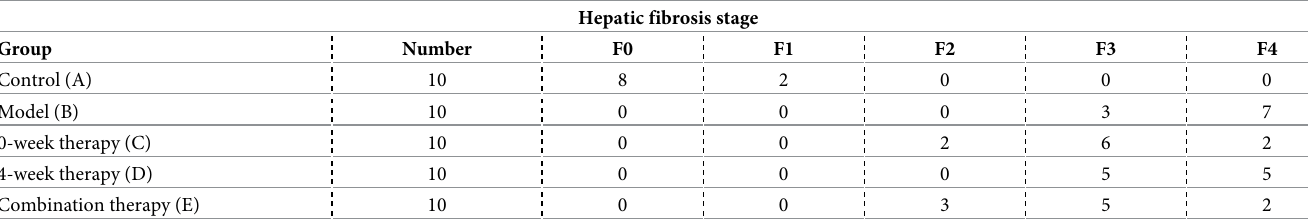
Table 1. Staging of hepatic fibrosis in rats of the different groups.